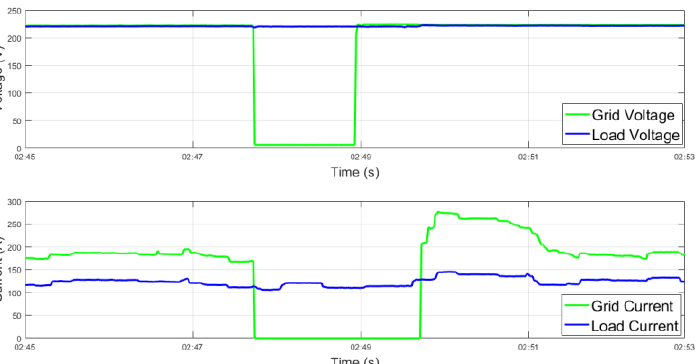
Figure 14. Actuation of the BESS as a voltage and frequency reference for the load during disturbance in the magnitude of the voltage of the utility grid.